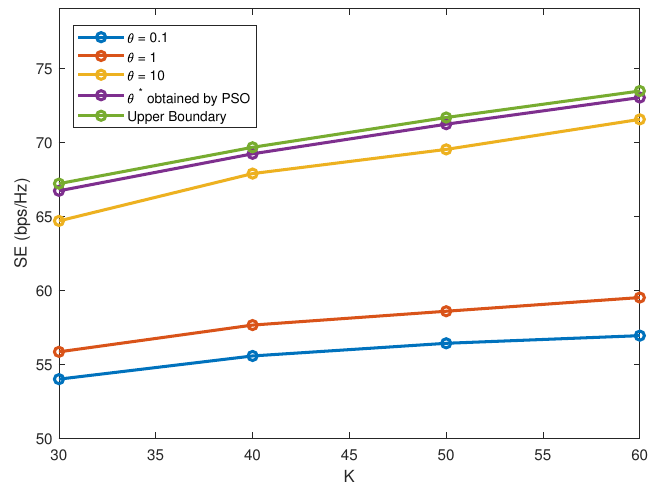
Figure 4. SE versus K under different θ